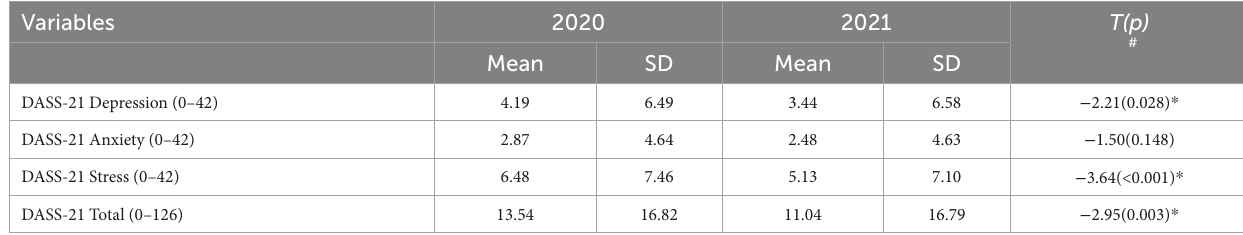
TABLE 2 Summary statistics for the DASS-21 study participants (t 1 and t 2 ) and comparison between 2020 and 2021 ( n = 305). Variables